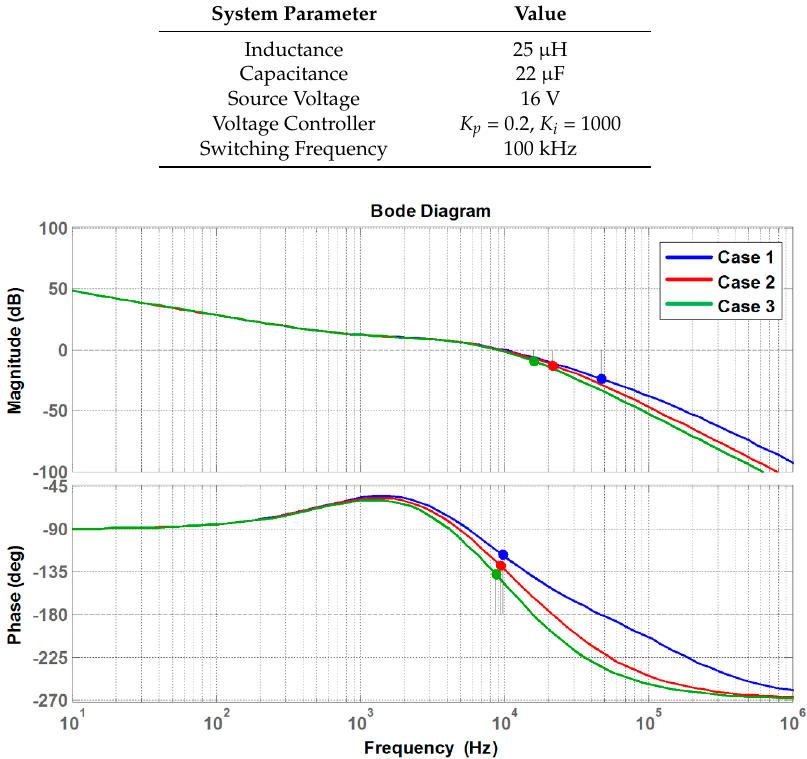
Figure 7. Bode plot of the loop gain with different sensor interface circuits.